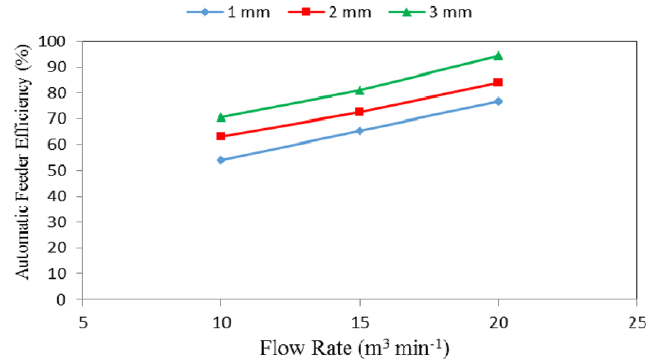
Figure 8. Automatic feeder efficiency at different feed pellet sizes and air flow rates.